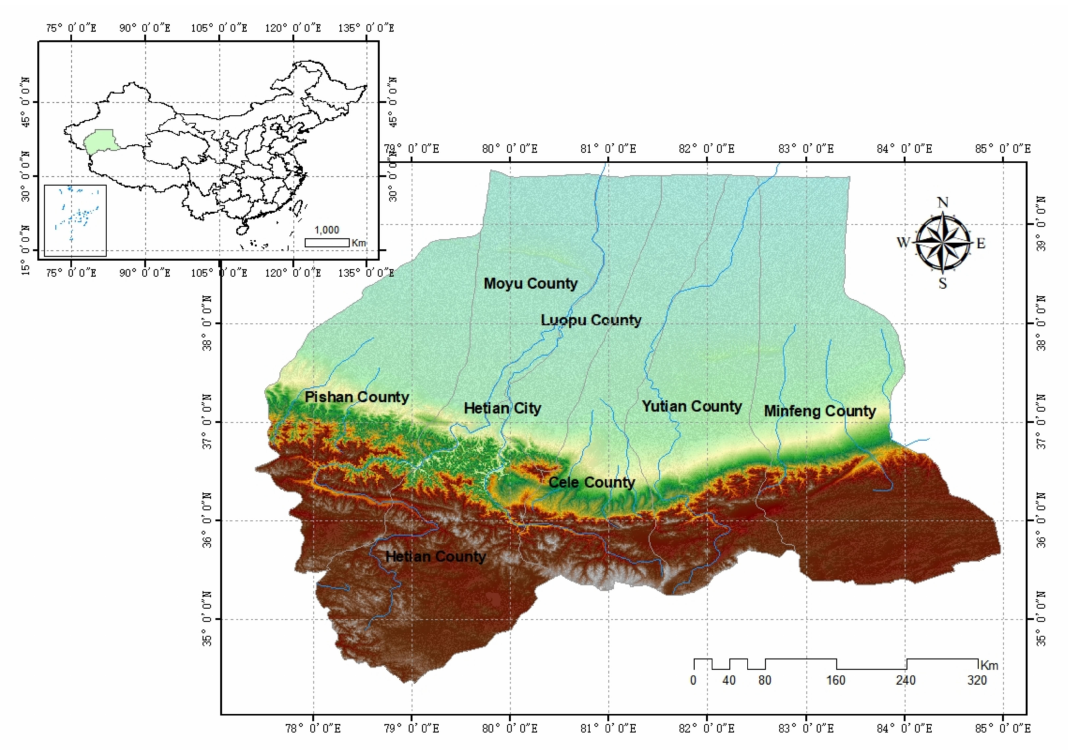
Figure 1. Geographical overview of